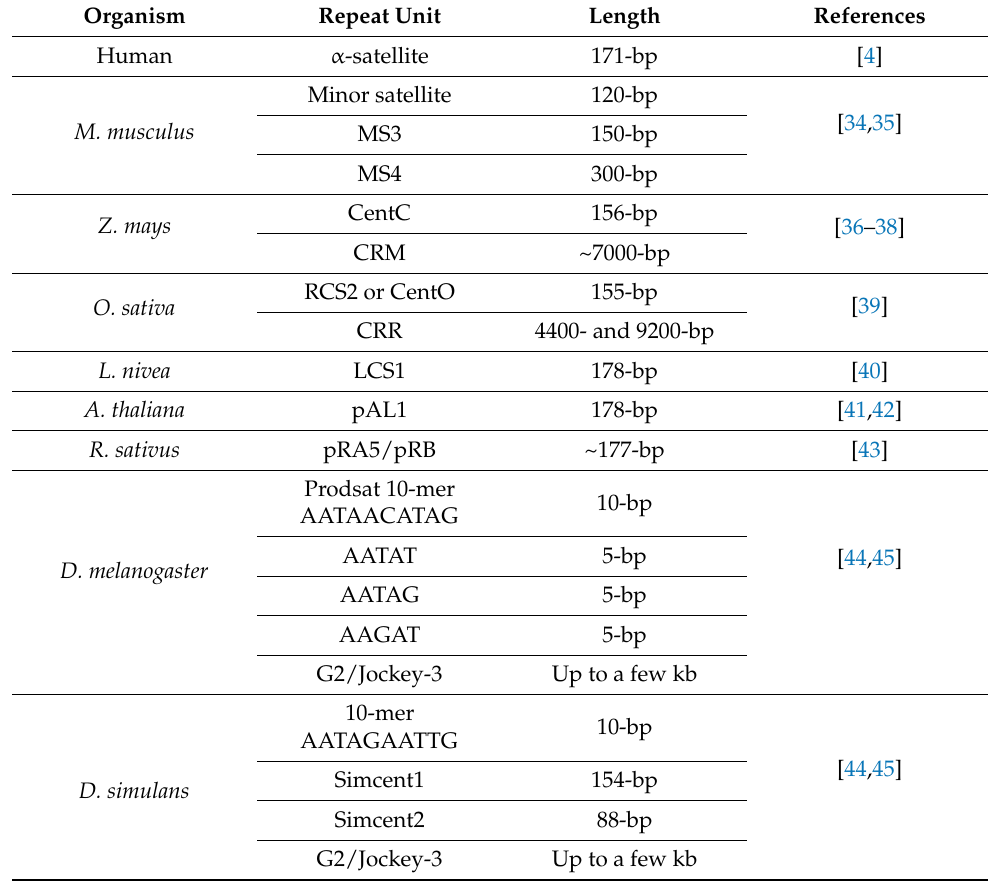
Table 1. Centromeric satellite repeat units of mammals, plants and insects.